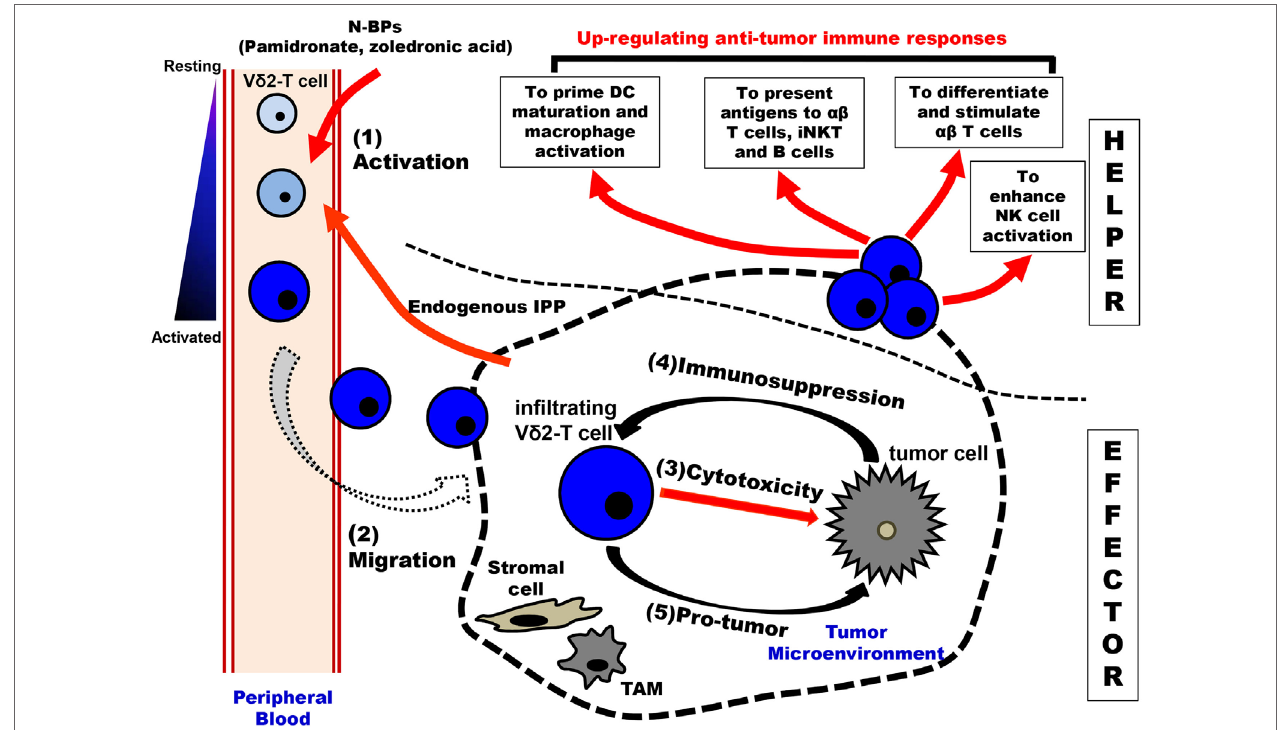
FigURe 2 | Schematic overview of immunological roles of V γ 9V δ 2-T cells in antitumoral surveillance. V γ 9V δ 2-T cells can make multiple contributions to antitumoral immunity, including “eFFeCToR” function and “HeLPeR” function. There are five steps involved in V γ 9V δ 2-T cell-associated effector functions: (1) Activation: upon stimulation by N-BPs (such as the administration of pamidronate) and increased-endogenous IPP produced by tumor cells, peripheral blood V γ 9V δ 2-T cells are activated in a T cell receptor-dependent manner. (2) Migration: the activated V γ 9V δ 2-T cells with an upregulated expression of chemokine receptors are recruited by gradient chemokines established by tumor cells. (3) Cytotoxicity: the infiltrating V γ 9V δ 2-T cells can recognize and kill tumor cells in the tumor site. (4) Immunosuppression: in the tumor microenvironment, tumor cells and other cells (like stromal cells and TAMs) produce immunosuppressive cytokines to induce the polarization of V γ 9V δ 2-T cells with Th-17 and Treg characteristics. Furthermore, the antitumoral activity of V γ 9V δ 2-T cells can be inhibited through the interaction of the inhibitory receptor and their corresponding ligands that are expressed by tumor cells and TAMs. (5) Pro-tumor: the polarized V γ 9V δ 2-T cells can secret IL-17 to support tumor growth directly. Moreover, IL-4, IL-10, IL-17, and TGF- β produced by the polarized V γ 9V δ 2-T cells not only recruit immunosuppressive MDSCs but also suppress innate and adaptive immune responses. Besides the “eFFeCToR” function, V γ 9V δ 2-T cells can also exhibit the “HeLPeR” functions in antitumor immune immunity. The activated V γ 9V δ 2-T cells can promote the maturation of DCs and the activation of macrophages. These V γ 9V δ 2-T cells can act as APC and initiate the differentiation and stimulation of tumor antigen-specific CD4 + T and CD8 + T cells. Moreover, V γ 9V δ 2-T cells can present antigens to iNKT and B cells. V γ 9V δ 2-T cells can promote NK cell antitumor response by delivering a costimulatory signal. APC, antigen presentation cell; DCs, dendritic cells; iNKT, invariant NKT cells; IPP, isopentenyl pyrophosphate; MDSCs, myeloid-derived suppressor cells; NK, natural killer cell; N-BPs, nitrogen-containing bisphosphonates; and TAMs, tumor-associated